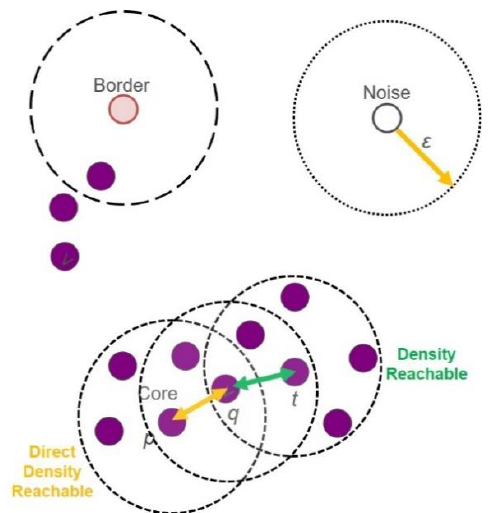
Figure 1. Density-Based Spatial Clustering of Applications with Noise (DBSCAN) example for Min. Points = 4.